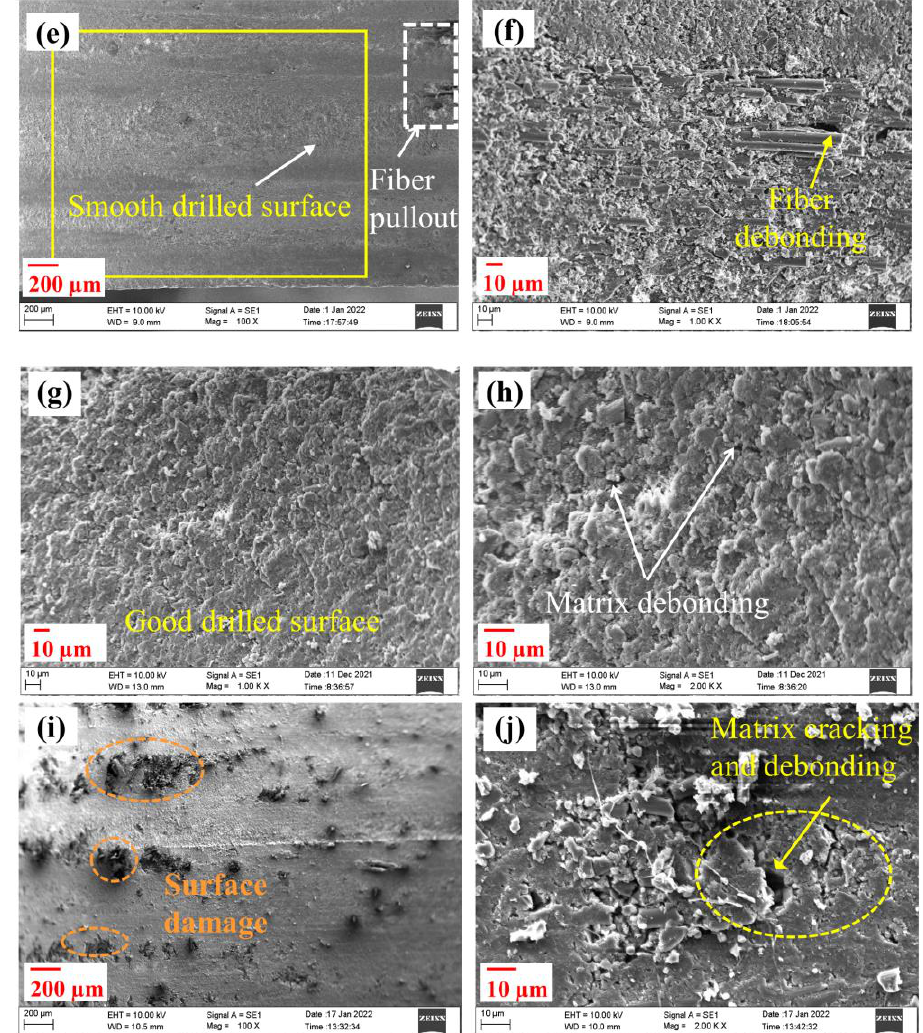
Figure 9. Morphology of MoS 2 -loaded CEC drilled at ( a , b ) A = 1000 rpm, B = 0.07 mm.rev −1 , C = 4 mm, D = 4 wt%; ( c , d ) A = 3250 rpm, B = 0.05 mm.rev −1 , C = 4 mm, D = 6 wt%; ( e , f ) A = 3250 rpm, B = 0.05 mm.rev −1 , C = 6 mm, D = 6 wt%; ( g , h ) A = 3250 rpm, B = 0.05 mm.rev −1 , C = 6 mm, D = 8 wt% and ( i , j ) A = 5500 rpm, B = 0.07 mm.rev −1 , C = 8 mm, D = 8 wt%.